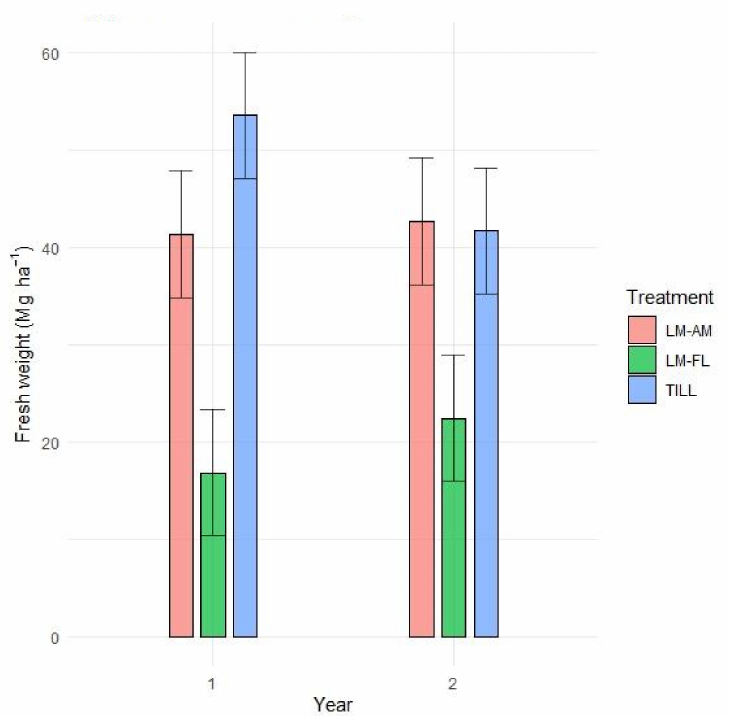
Figure 5. Effect of treatments (TILL, LM-FL, LM-AM) and years (1 is 2020, 2 is 2021) on eggplant fresh marketable yield. Error bar represents the upper and lower limits of the 95% confidence